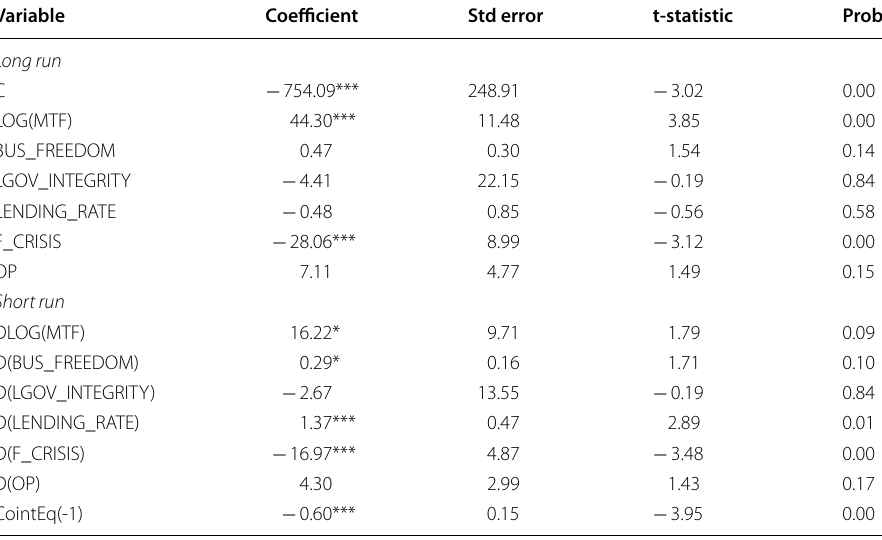
*, ** and *** indicate significance at the 10%, 5%, and 1% levels respectively